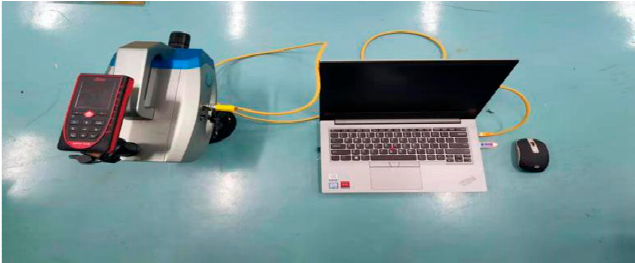
Figure 28. SMTN-X Pro multi-point dynamic video measurement system.